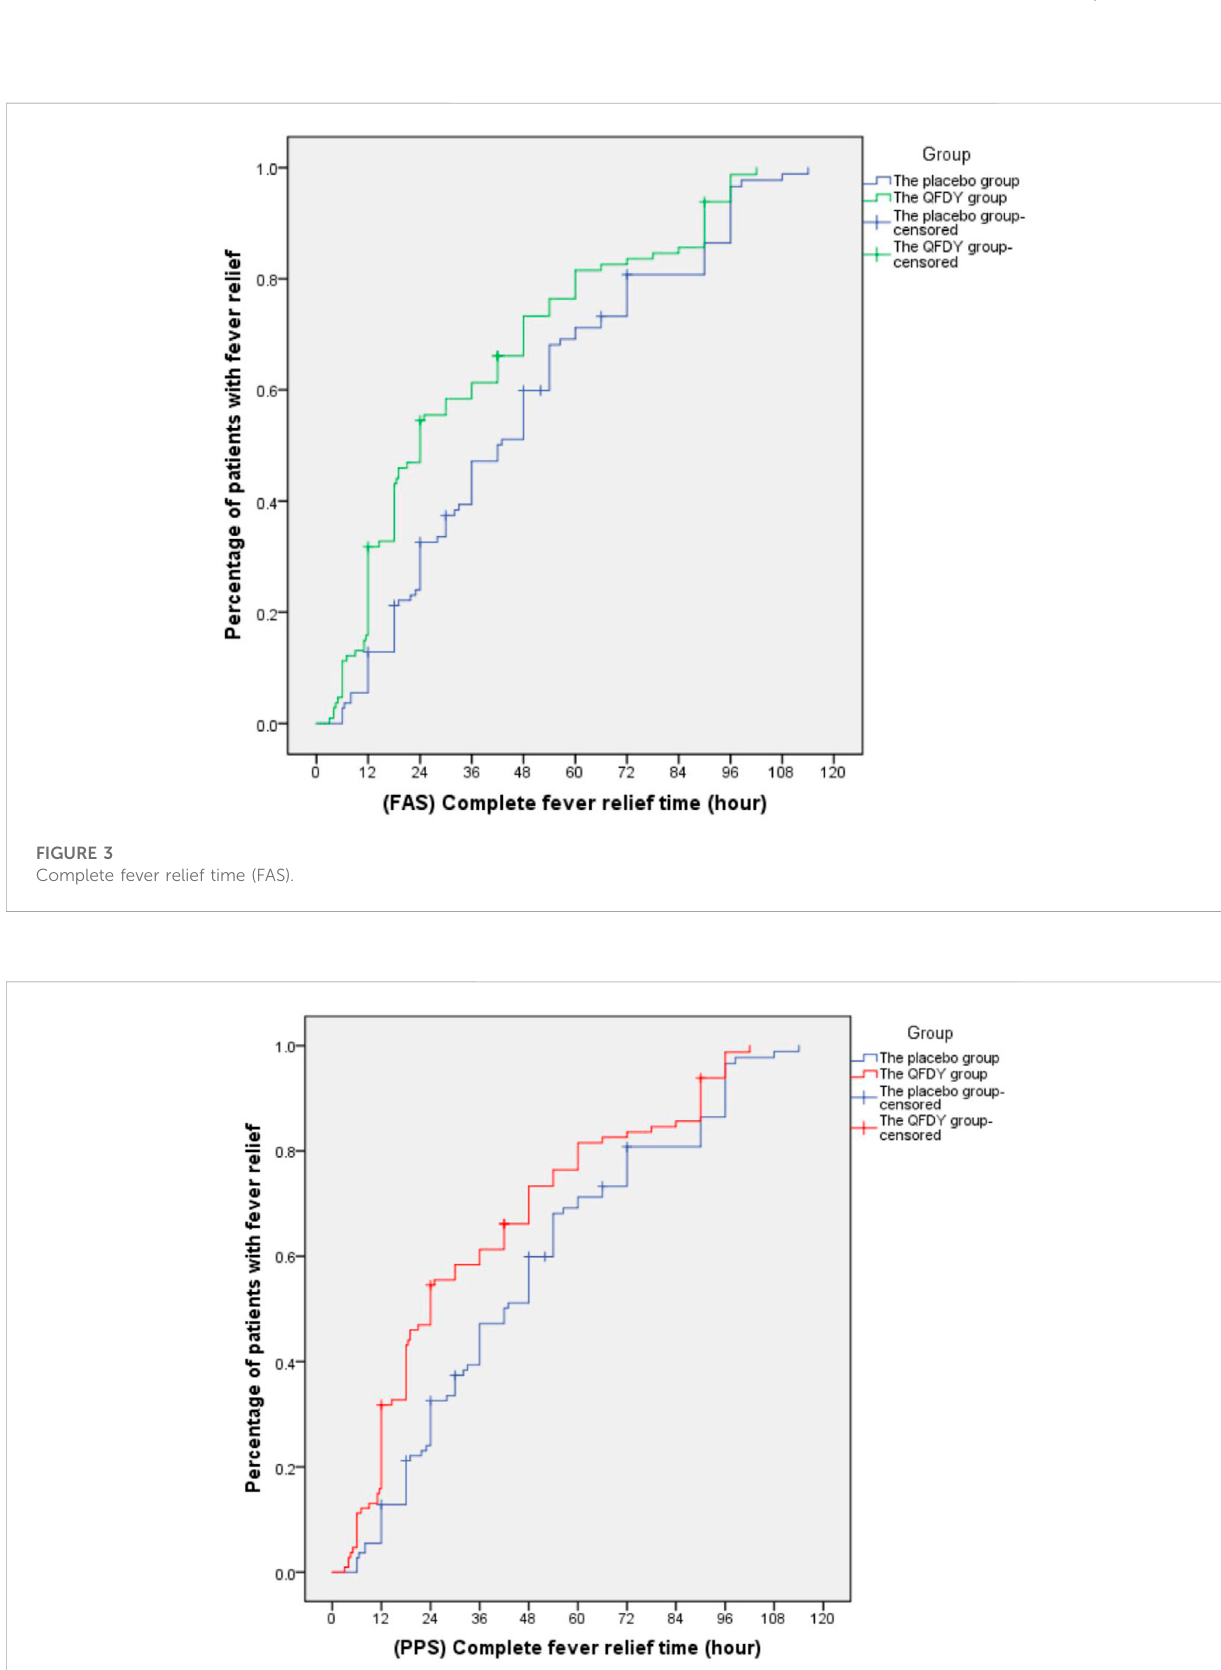
FIGURE 4 Complete fever relief time